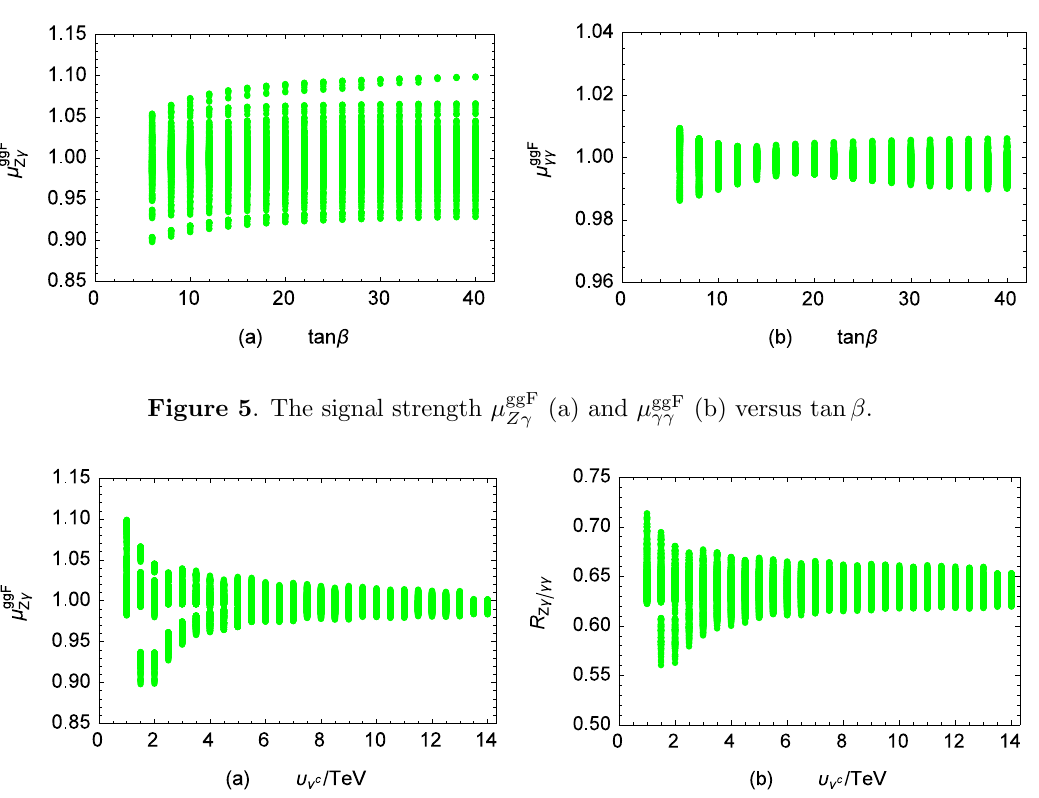
(a) and the ratio R Z(cid:13)=(cid:13)(cid:13) (b) versus the parameter (cid:29) (cid:23) c Z(cid:13)